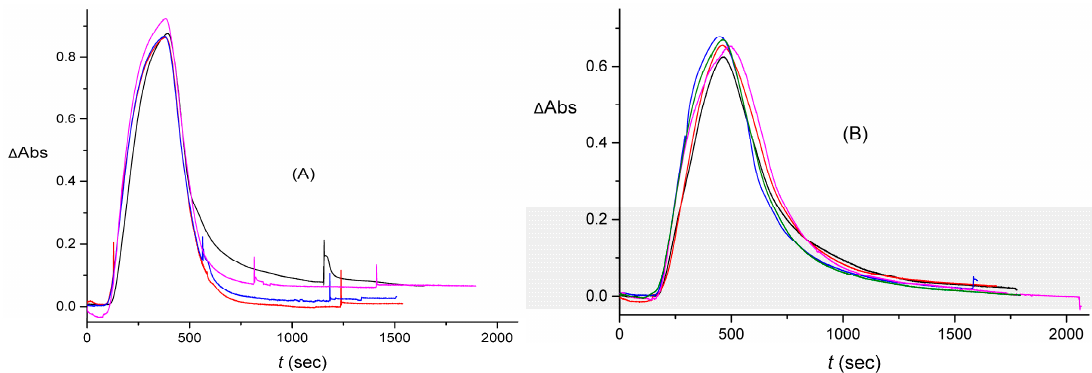
Figure 1. Example of the output signal, S p t q , measured as the change of the absorbance (with respect to the background) in the cuvette as a function of time. ( A ) Four different experiments for the rectangular input pulse; ( B ) Five experiments for the triangular input pulse. Both data sets were obtained without the enzymatic reaction. The optical absorbance was measured at λ = 420 nm, corresponding to λ max in the absorbance spectrum of [Fe(CN) 6 ] 3 − .